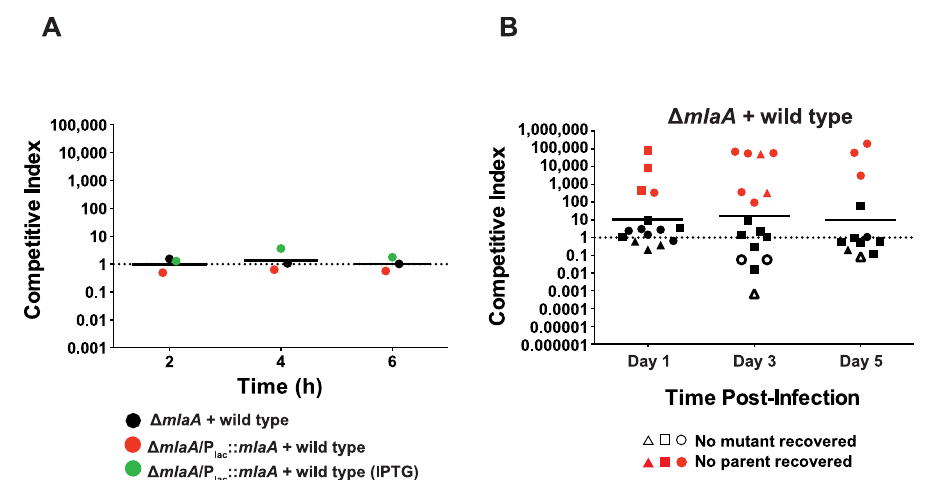
Fig 8. MlaA influences gonococcal fitness in vivo . (A) In vitro competition assays were performed by combining WT FA1090 bacteria with approximately equal numbers of Δ mlaA or Δ mlaA /P lac :: mlaA (~10 6 CFU total bacteria). Competitions were carried out in liquid medium, and output CFUs were assessed at 2, 4, and 6 h post-inoculation. Competitions with the complemented strain were performed in liquid medium both with and without IPTG. (B) Female BALB/c mice were inoculated intravaginally with approximately equal numbers of CFUs of WT and Δ mlaA bacteria (~10 6 CFU total N . gonorrhoeae ; 7 mice per group). Vaginal swabs were taken on days 1, 3, and 5 post- infection and were cultured for CFU/mL enumeration on solid media containing streptomycin (total bacteria) or media containing streptomycin and kanamycin ( Δ mlaA bacteria). Experiments were repeated three times and results are expressed as the geometric mean of the competitive index (CI): [mutant CFU (output) / WT CFU (output)] / [mutant CFU (input) / WT CFU (input)]. A CI > 1 indicates that the mutant was more fit during the competition. 1 CFU was assigned for any strain not recovered from an infected mouse. IPTG, isopropyl β -D-thiogalactopyranoside; CFU, colony forming unit.